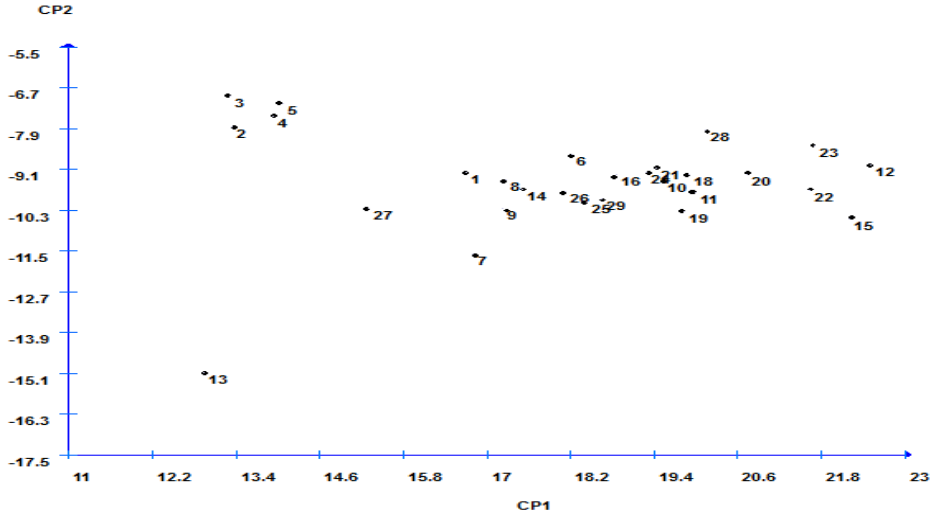
Figure 4. Biplot analysis for 15 traits across 29 genotypes; numbers 1, 2, 3… 29 represent the genotypes numbers, according to the serial number shown in Figure 1.